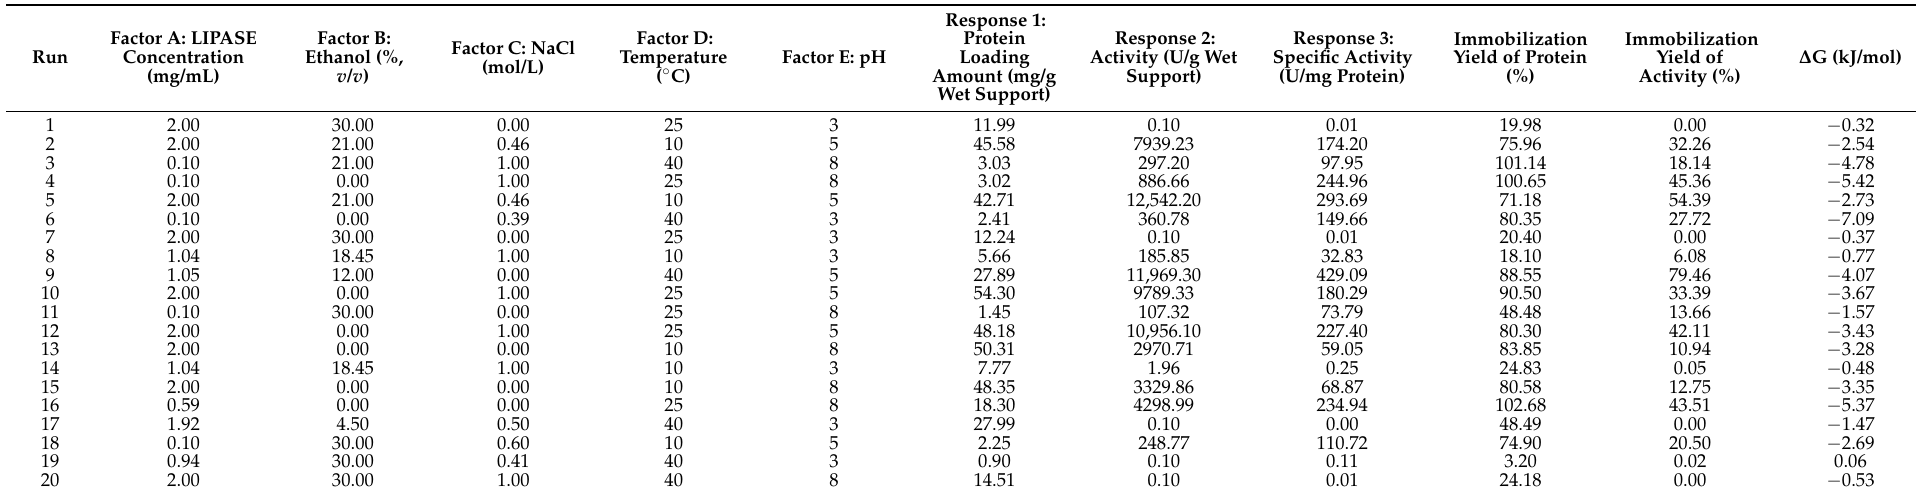
Table 1. Factors and responses in factor screening experimental design and Gibbs free energy for each